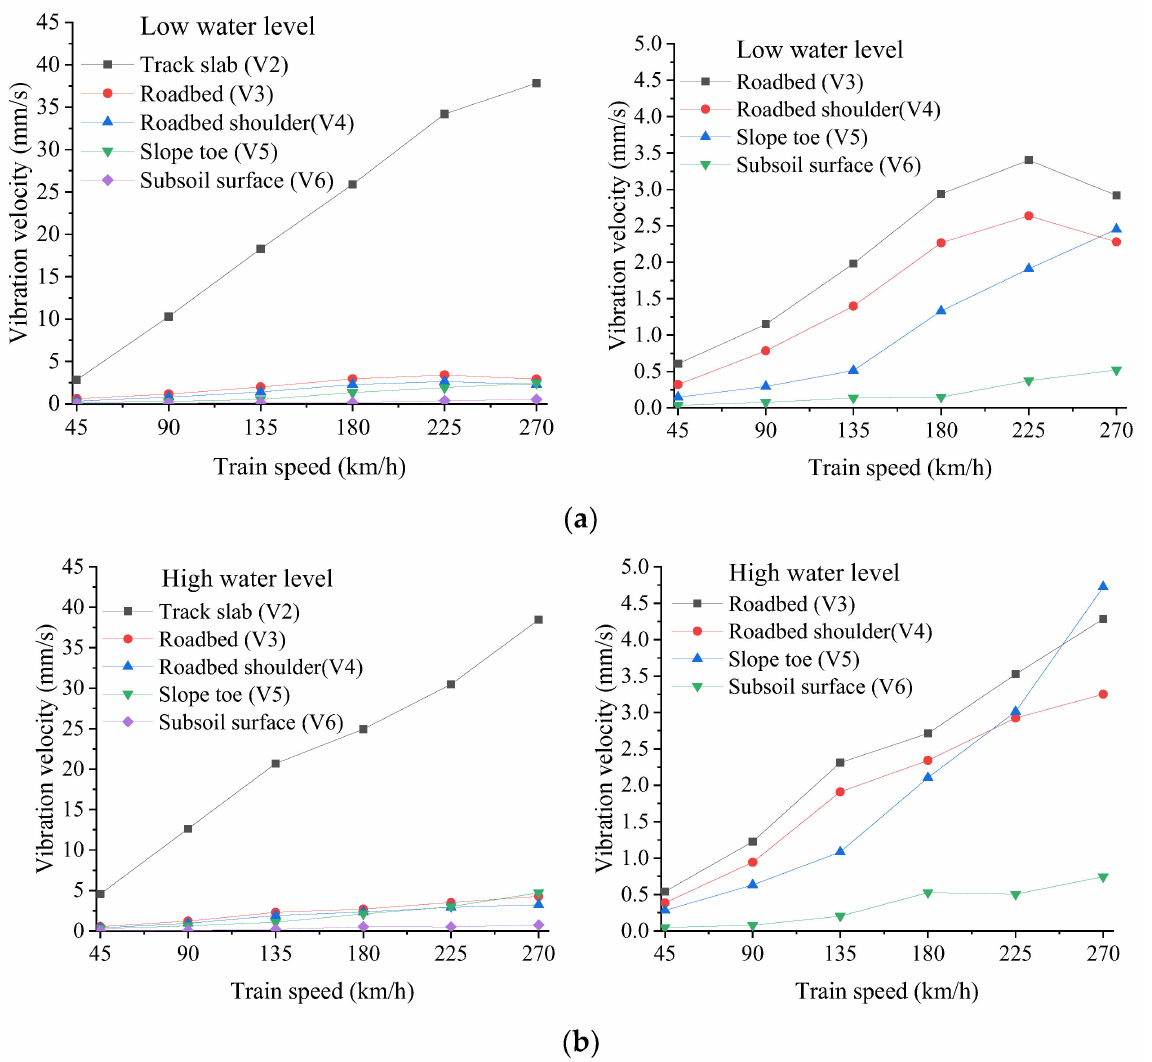
Figure 16. Relationship between vibration velocities and train speed at V3 to V6. ( a ) low water level, ( b ) high water